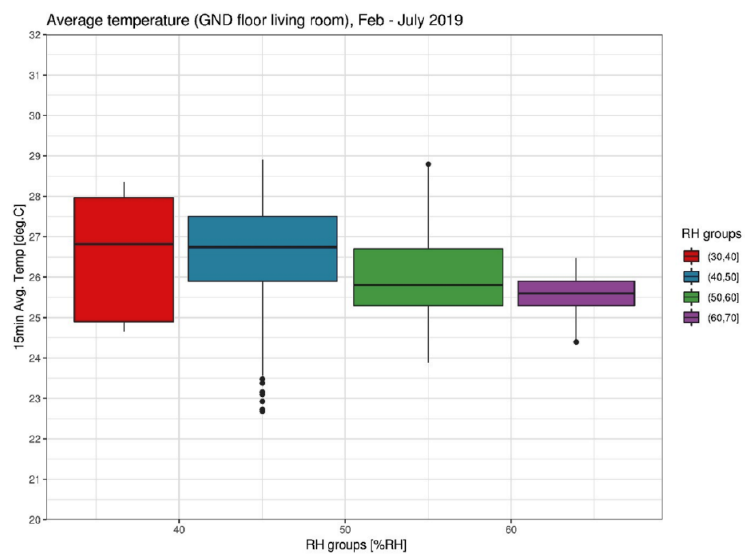
Figure 7. Temperature and RH boxplots for ground floor kitchen from February to July 2019.